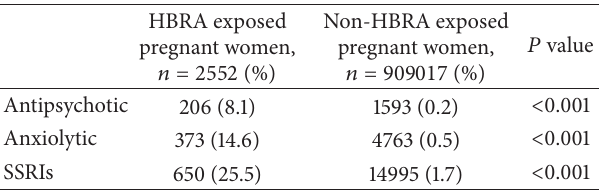
Table 2: HBRA exposed and nonexposed pregnant women and combined use of psychoactive